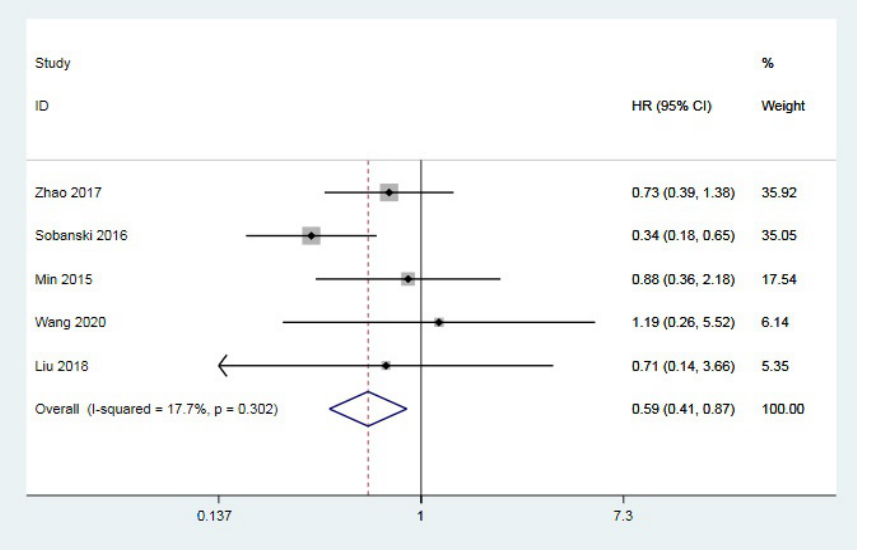
Figure 3. Forest plot of the relationship between anti-U1 RNP antibody positivity and mortality of CTD-PAH. HR: hazard ratio; CI: confidence interval [11,14,29,30].